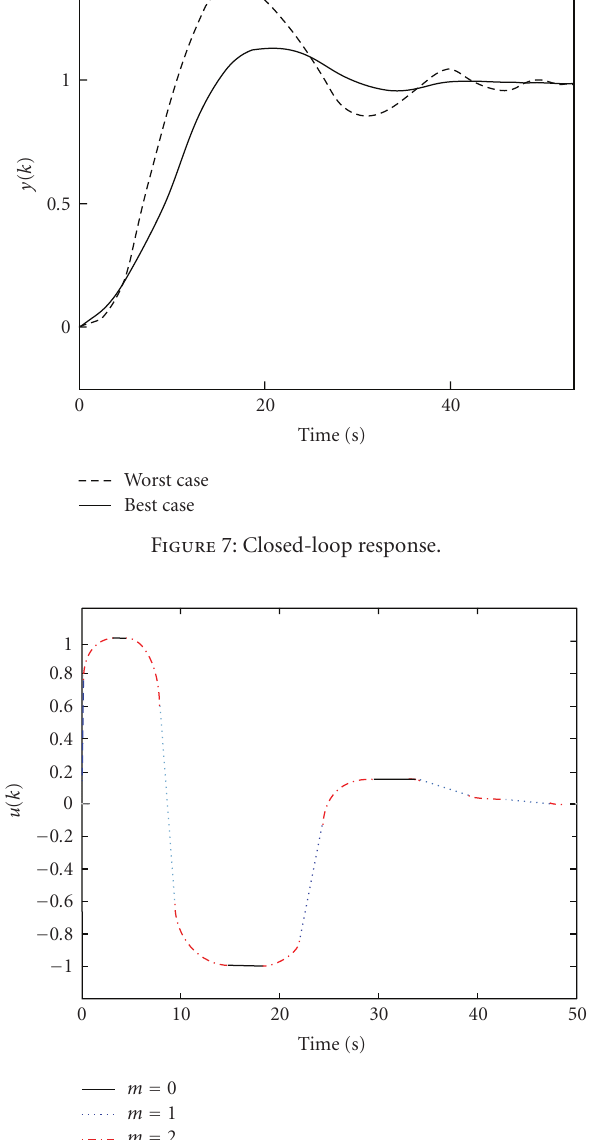
Figure 8: Illustration of Switching ways of sampling functions in the interpolation.